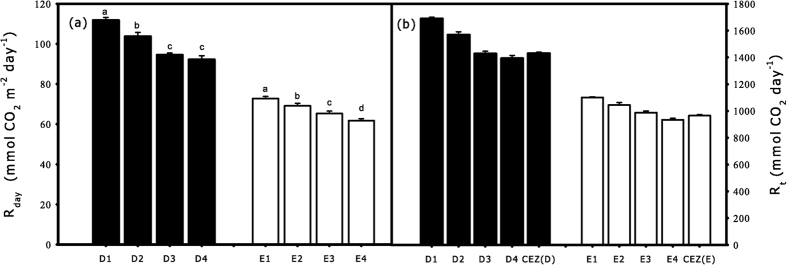
The cumulative respiration rates (Rday) of CEZs (D1, D2, D3, D4, and E1, E2, E3, E4) and total crown respiration (Rt) estimated by a uniform Rdand CEZs method on crown scales.Rday and Rt were shown under sunny (closed bar) and cloudy (open bar) conditions, CEZ(D) and CEZ(E) were Rt estimated by using CEZs method respectively under sunny and cloudy conditions. Identical letters indicate homogeneous groups with statistically insignificant differences (p > 0.05). n = 6.